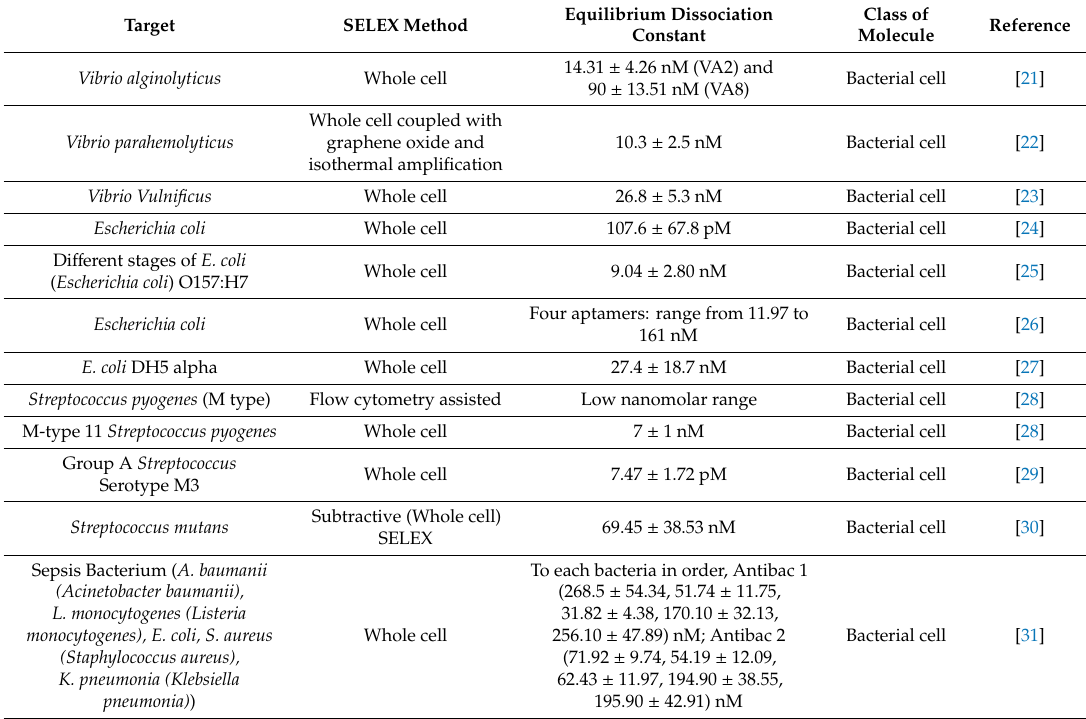
Table 1. Summary table of new single-stranded DNA (ssDNA) aptamers selected against bacteria and bacterial related